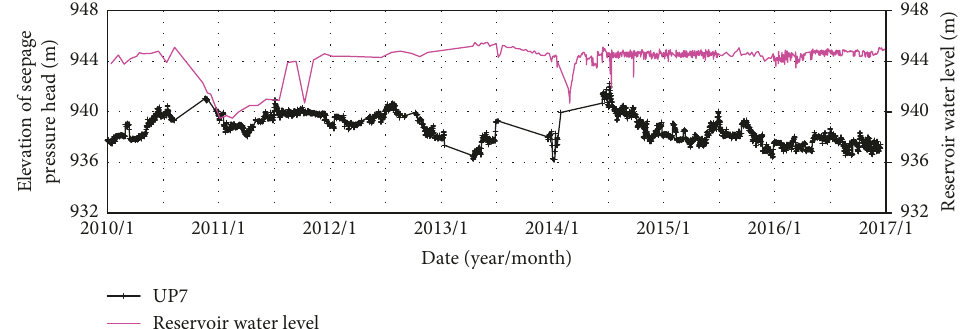
Figure 11: Time series for seepage pressure head at UP7 and reservoir water level.